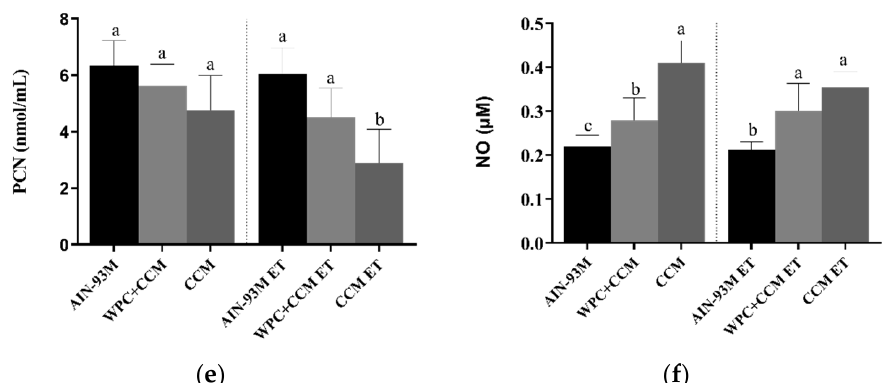
Figure 2. Analysis of oxidative balance in muscle. AIN-93M: group that received a standard diet;